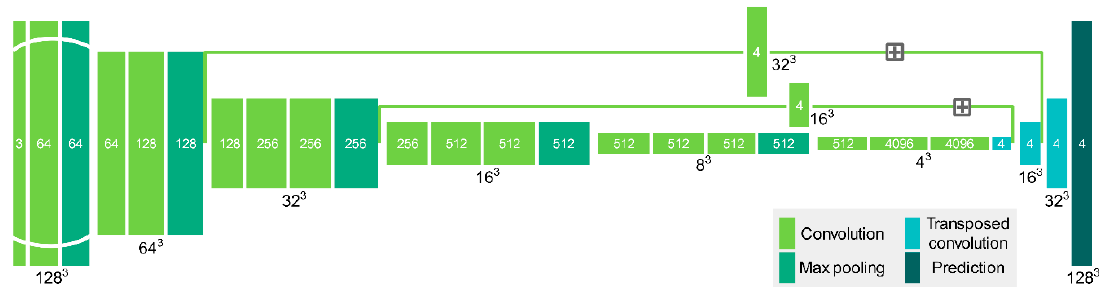
Figure 3. Configuration of 3-D FCN structure. Colored bars denote different types of network layers, black numbers outside bar denote input size in 3-D domain, white numbers inside bar denote input size in feature domain, and gray plus sign denote addition of layer outputs.